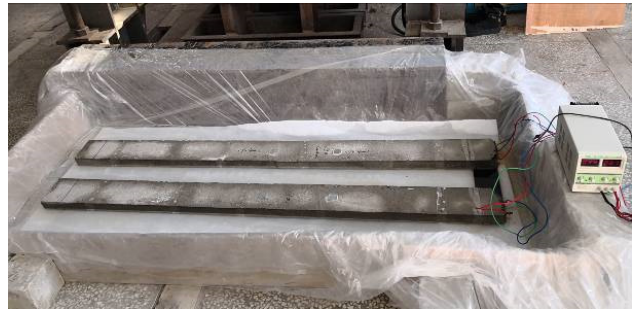
Figure 4. Experimental setup for accelerated steel corrosion.